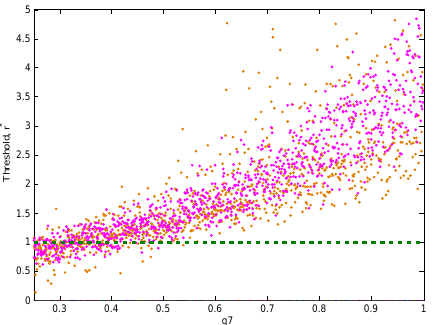
Figure 6. Sensitivity of the threshold level, r ∗ , to vaccine uptake, q 7 . The transmission rate β ranges between 0.7 and 0.75 (brown dots) or between 0.85 and 0.90 (pink).